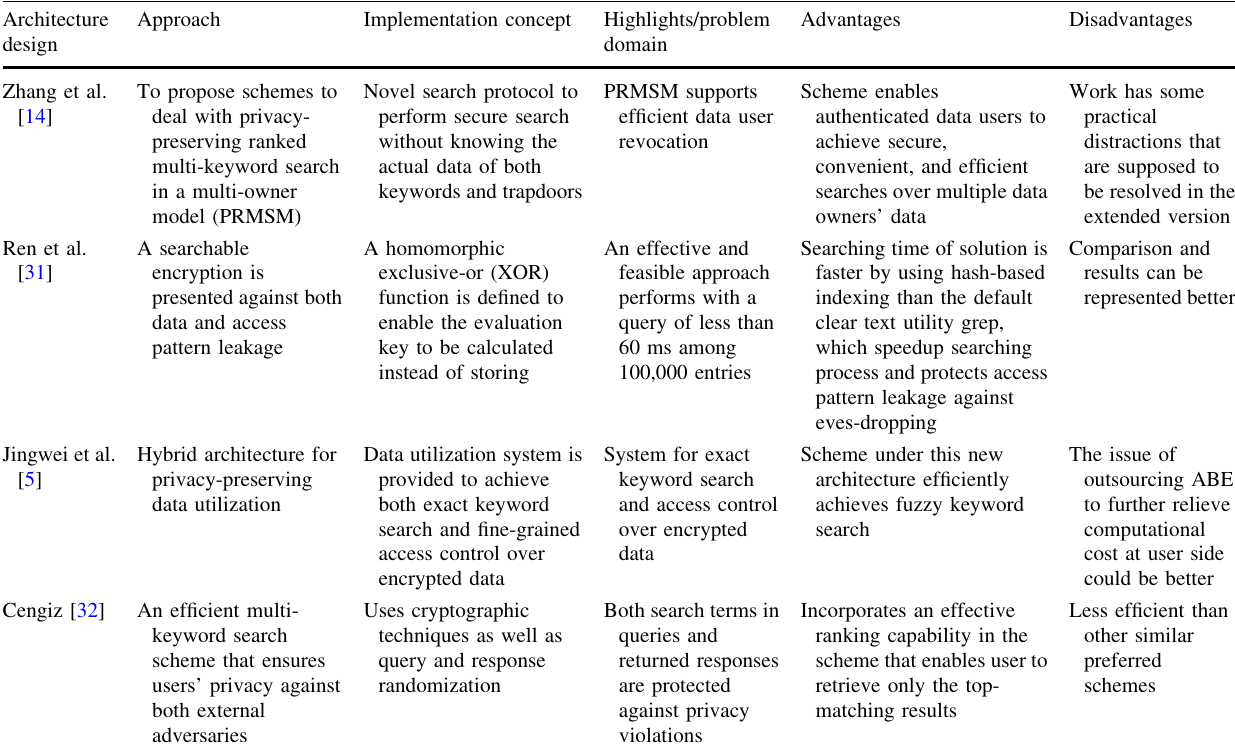
Table 5 Comparison of ranking-based evaluation approaches Architecture